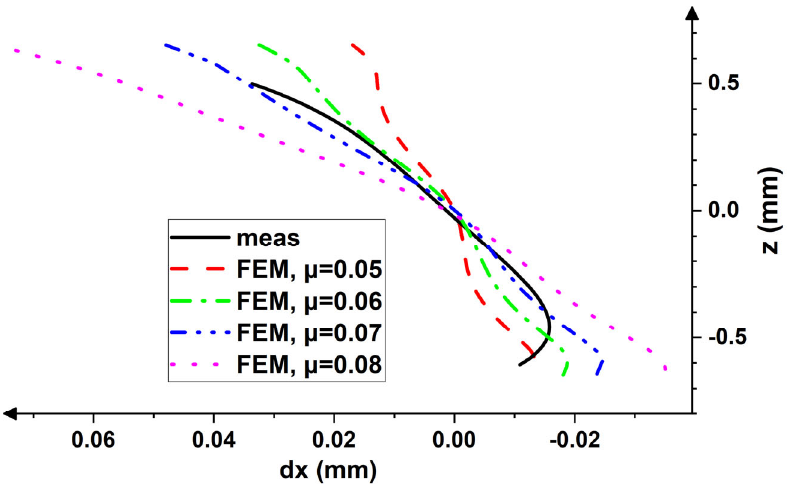
Figure 11. Experimental and simulated displacement patterns across the thickness of asymmetrically rolled sheet.